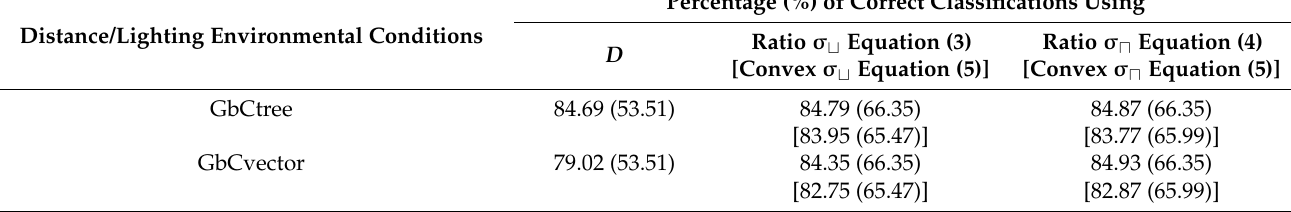
Figure 8. A rule R, induced from data of the class “happiness”, defines a granule of primary /secondary feature vectors by a conjunction of 25 annulus (ring) sectors in its antecedent. Underlined annulus (ring) sectors 21 and 23 are displayed in Figure